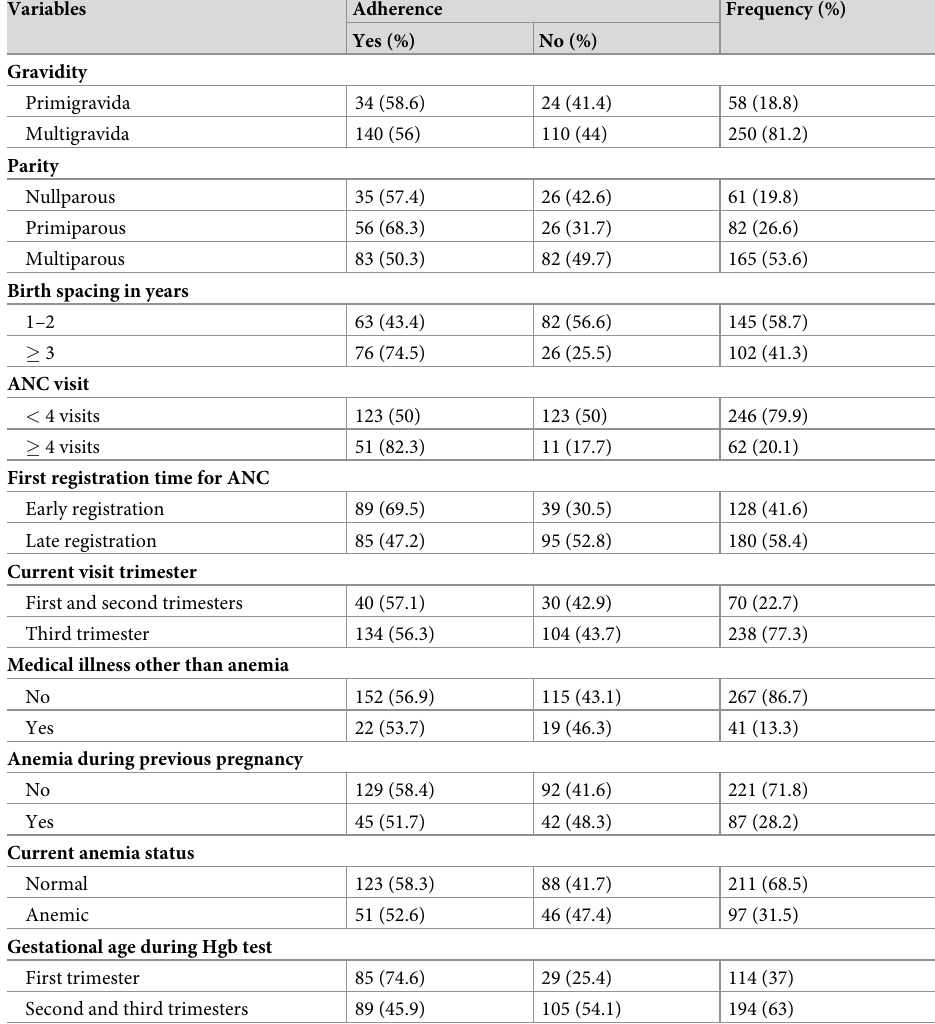
Table 2. Obstetrics and health related characteristics of pregnant women attending antenatal care in public health facilities Dire Dawa, Eastern Ethiopia. n =